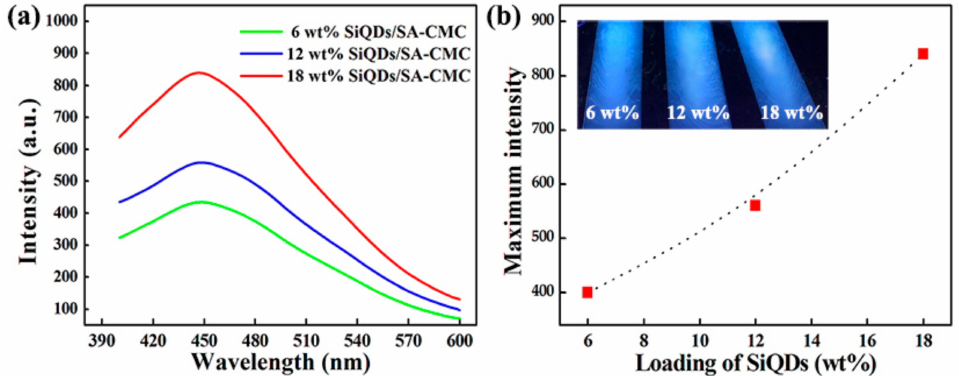
Figure 7. ( a ) PL spectra (ex = 365 nm) and ( b ) maximum intensity of SiQDs / SA-CMC nanocomposites. Inset in ( b ) is digital photographs of SiQDs / SA-CMC nanocomposite films under 365 nm UV lamp